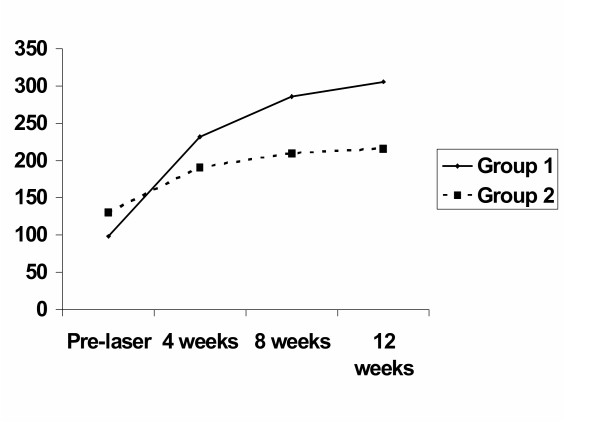
Contrast Sensitivity – Group 1 (Diode) Vs Group 2 (Argon green)